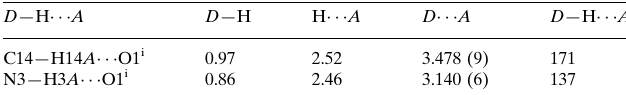
Hydrogen-bond geometry (A˚ , (cid:2)